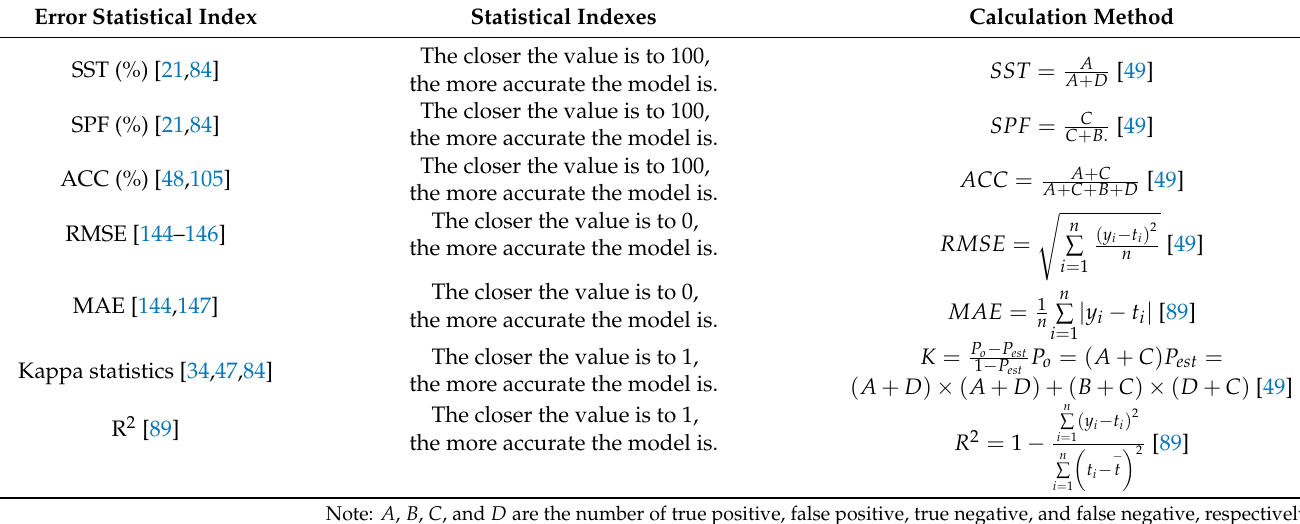
Table 11. Statistical